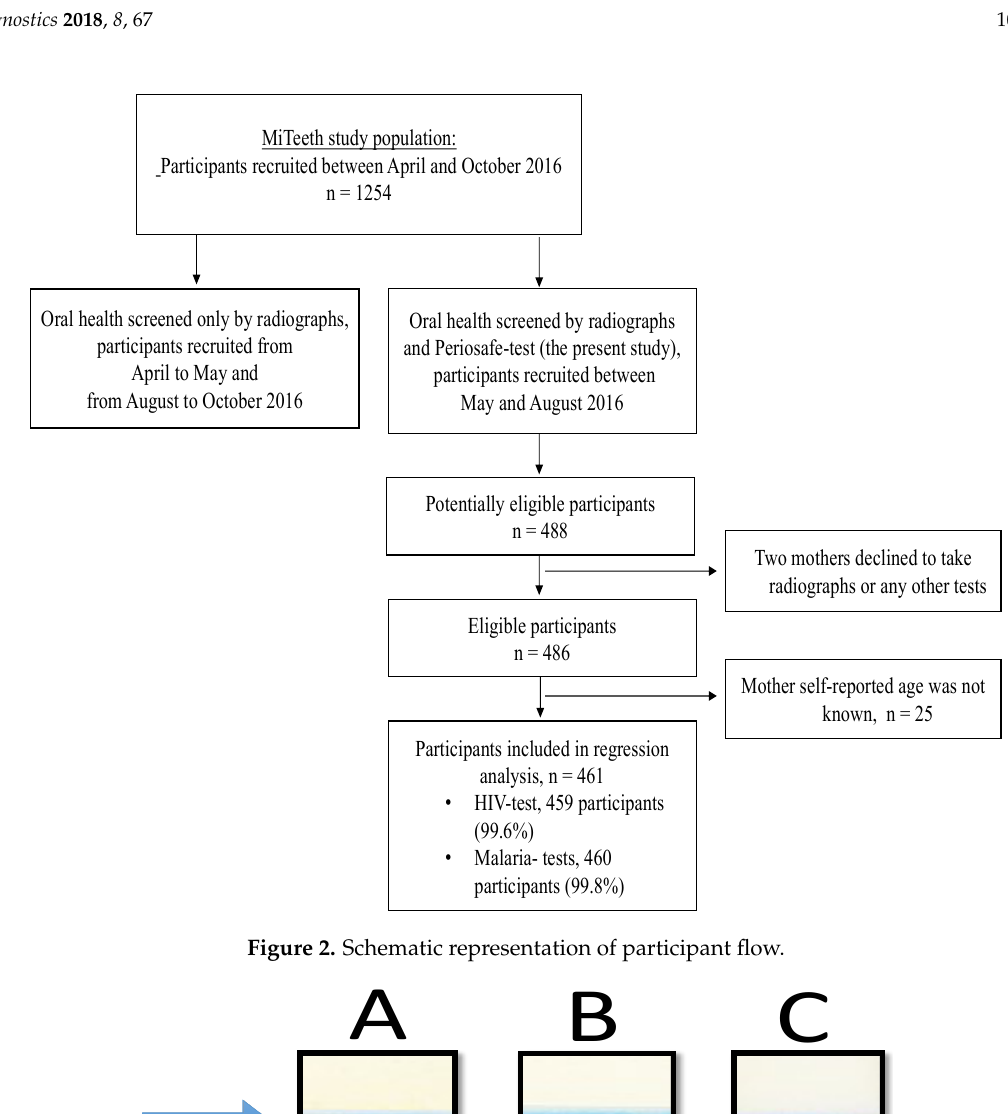
Figure 3. Example results of aMMP-8 point-of-care lateral flow immunotest. Two lines (indicated by arrows, ++, strong second line, lane A ) indicate elevated risk for periodontitis and alveolar bone loss; even a thin second (indicated by arrows, +, weak one, lane B ) line indicates elevated risk for periodontitis. One line indicates no risk for periodontitis (indicated by arrows, –, no second line, lane C ).